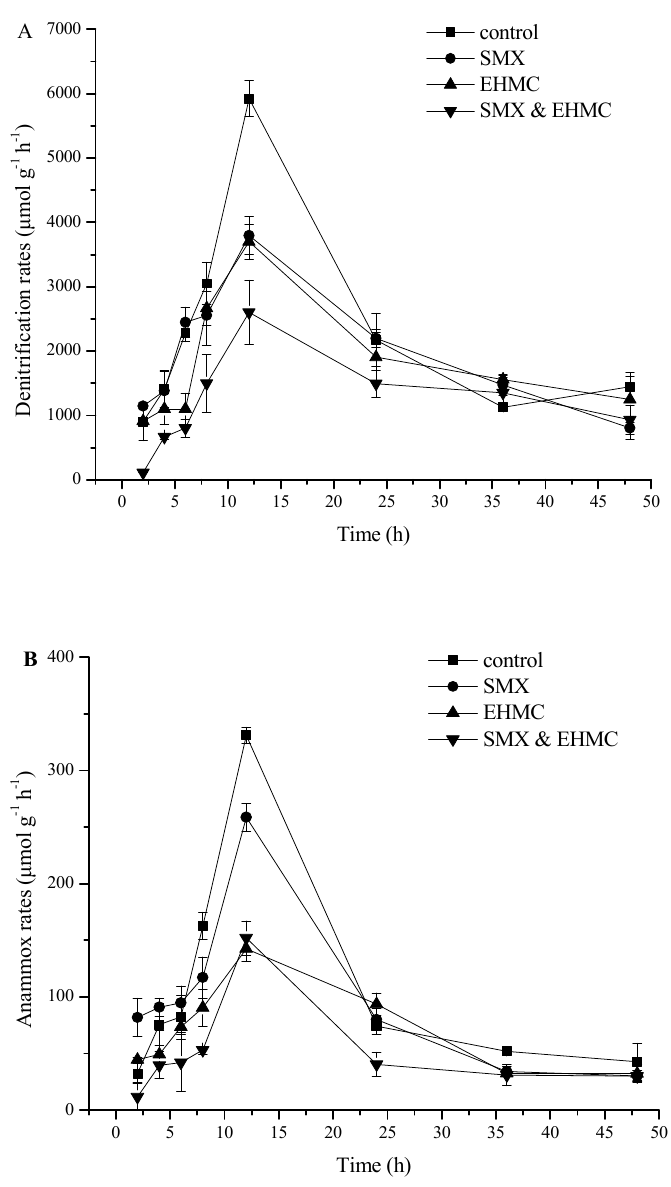
Figure 2. Time series changes in the rate of denitrification ( A ) and anammox ( B ) under the e ff ect of PPCPs. Control indicates the group with no injected pollutants; SMX, EHMC, and SMX&EHMC treatments mean that a group was spiked with SMX alone, EHMC alone or a combination of SMX and EHMC (final concentration of 1 µ g L − 1 ). The values are the means and the error bars represent the standard deviations (n = 3).